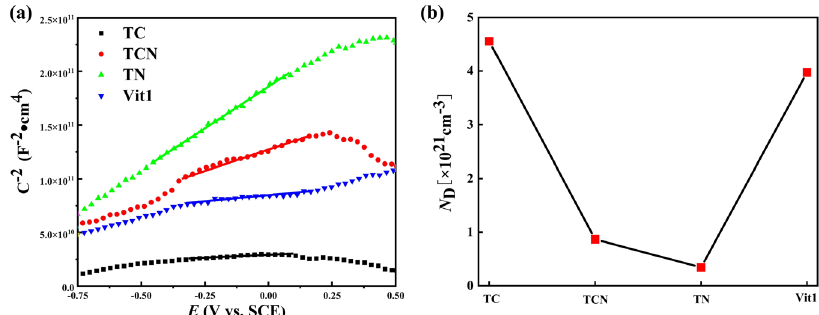
Fig. 5 M – S results of the samples after immersion in 3.5 wt. % NaCl for 3 h at 298 K. a M – S curves ( b ) Donor densities ( N D ) in the passive fi